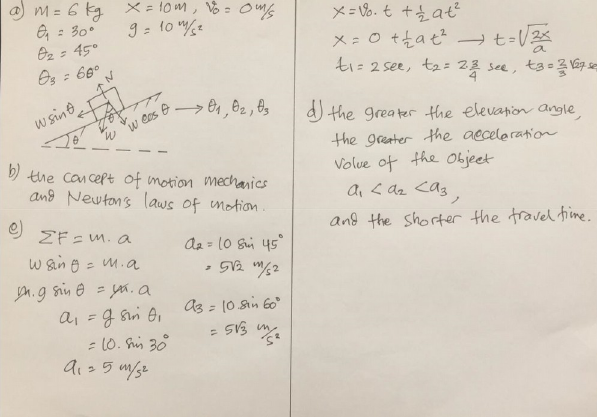
Figure 3. Examples of student answers